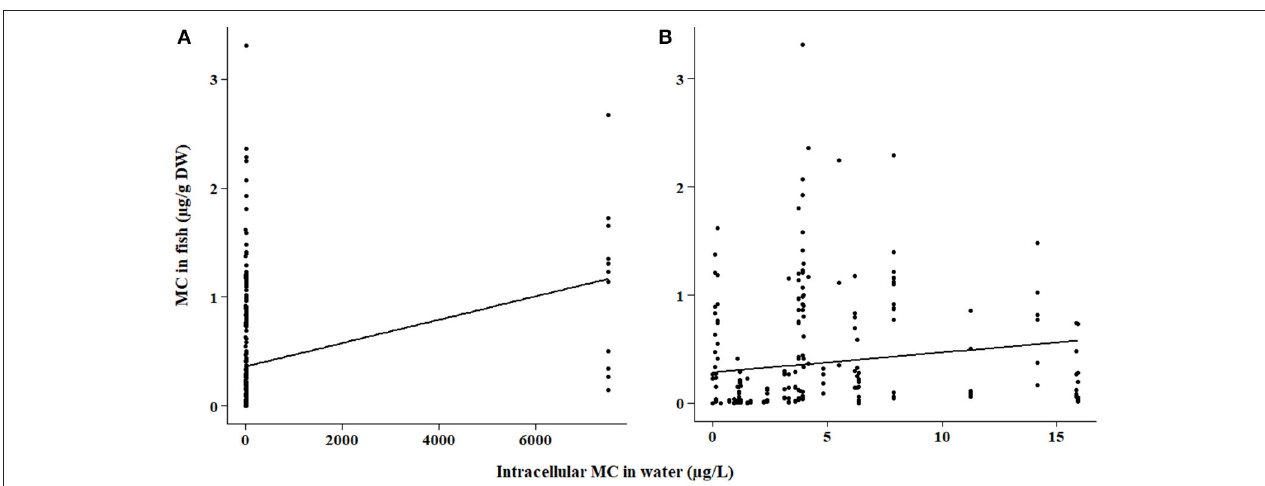
Frontiers in Marine Science |